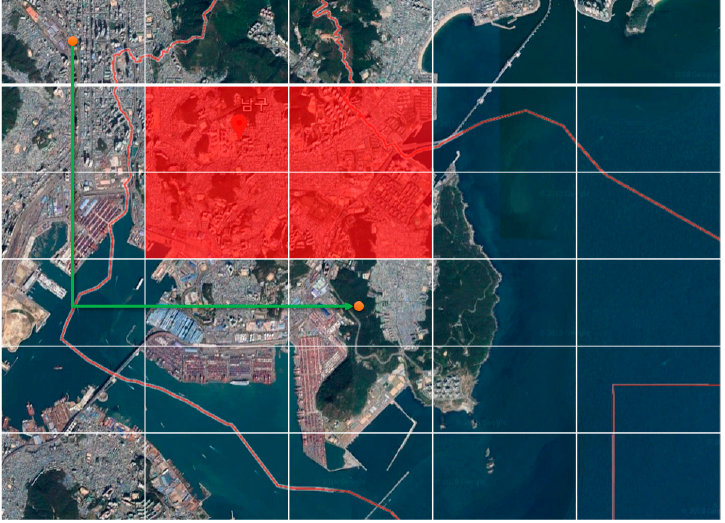
Figure 29. Sectoring the area expressed in the map provided by Google Earth.